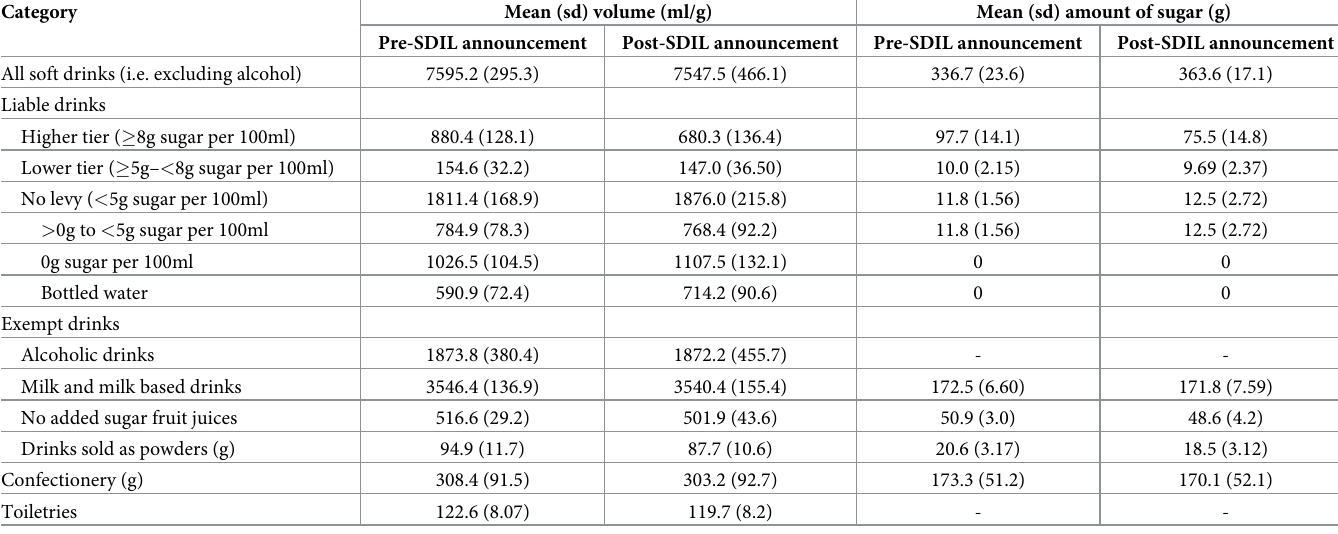
Table 1. Unadjusted mean (sd) volume of, and amount of sugar in, purchased drinks and confectionery per household per week pre- and post-announcement of the Soft Drinks Industry Levy, March 2014 to March 2018.